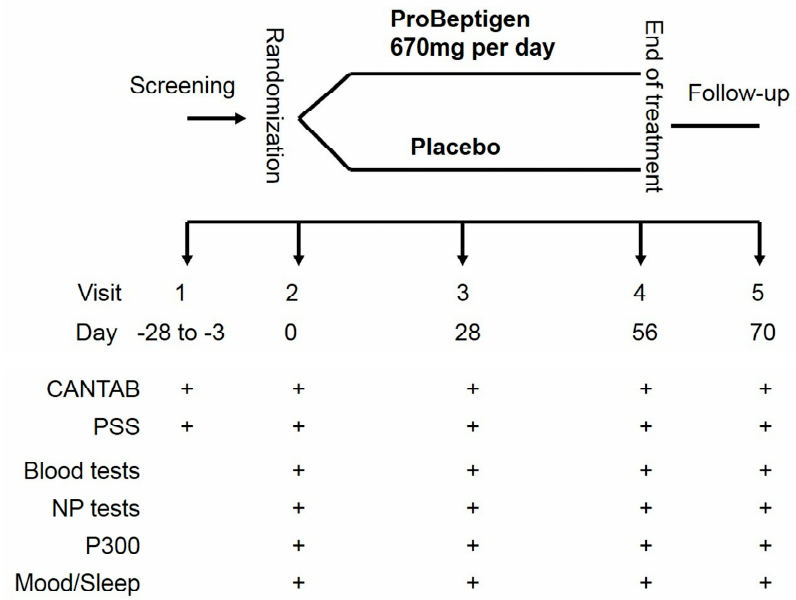
Figure 1. The study protocol. CANTAB, Cambridge Neuropsychological Test Automated Battery; The symbol of “ + ” denotes the examination performed at that visit. NP, neuropsychological; PSS, Perceived Stress Scale; P300, event-related potential.